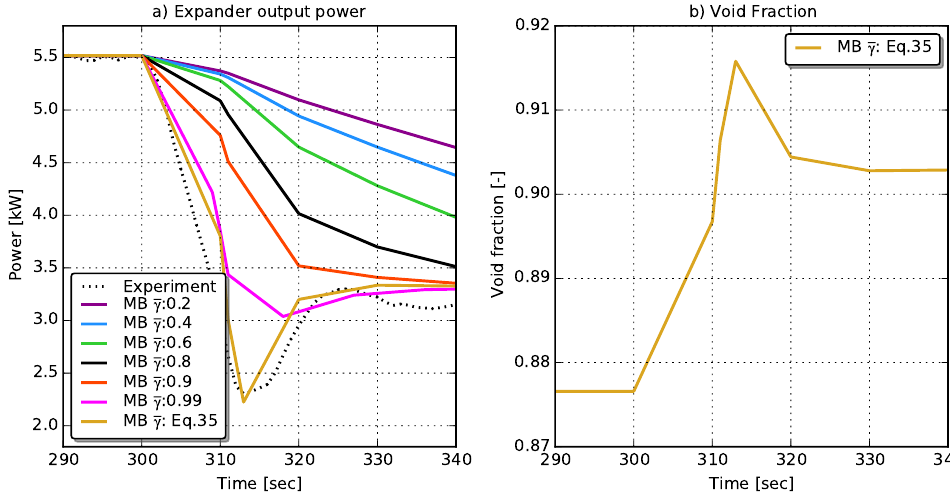
Figure 5. Results of the void fraction parametric analysis for the MB evaporator model. ( a ) Expander output power for different void fraction values in the MB evaporator model. ( b ) Void fraction trend in the MB evaporator model when analytically